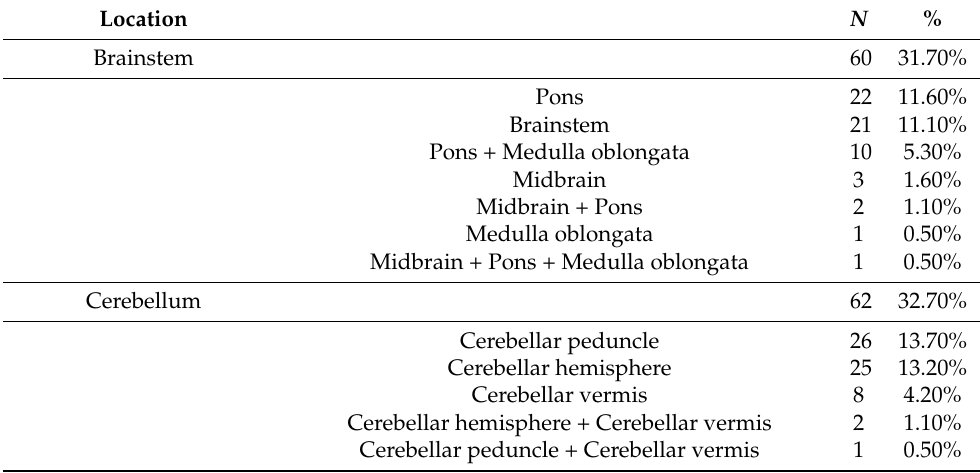
Table 2. Prevalence of tumors at various locations